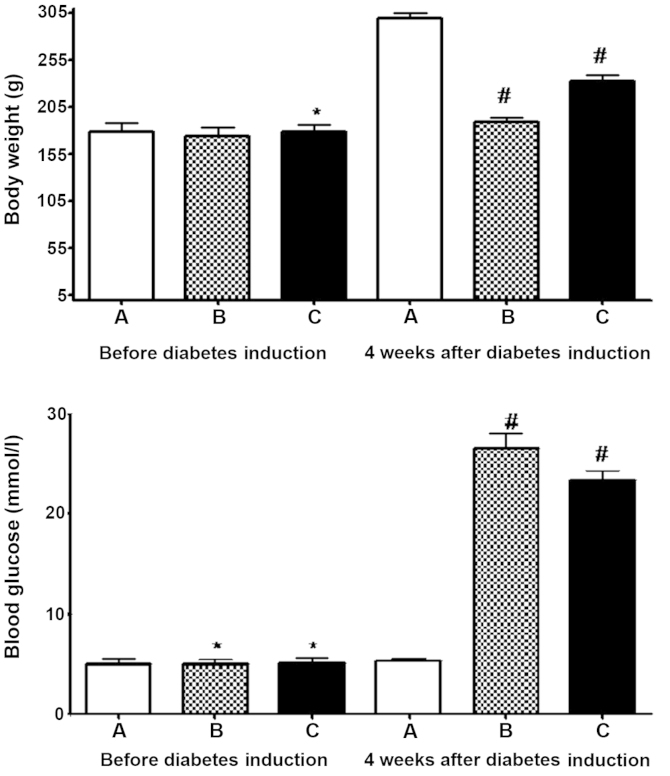
Body weight and blood sugar level of each group prior and subsequent to diabetes induction. A, normal control rats; B, diabetic rats; C, Salvia miltiorrhiza-treated rats. *P>0.05 and #P<0.05 vs. the normal rats.